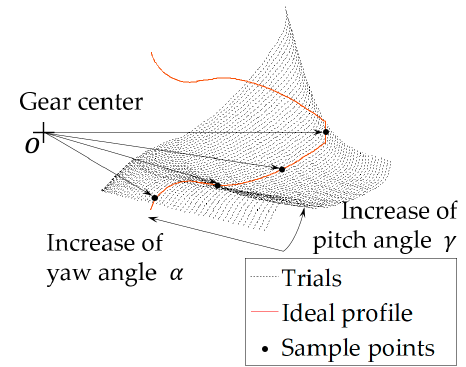
Figure 3. Illustration of the optimization process, note the direction of profile trials versus the increase of the pitch angle α and the yaw angle γ of the LTS mounting orientation. A mesh size of 50 × 60 of the pitch and yaw angles pairs is trialed within the ( − 10,10) bounds. The absolute radial error between the ideal and trial profiles are compared at the sampled points in a polar coordinate system with the origin identical to that of the gear center.